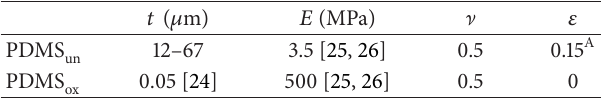
Table 1: A list of the estimated and measured values used for the calculation of the elastic deformation energy for bending and the curvature of the rolled